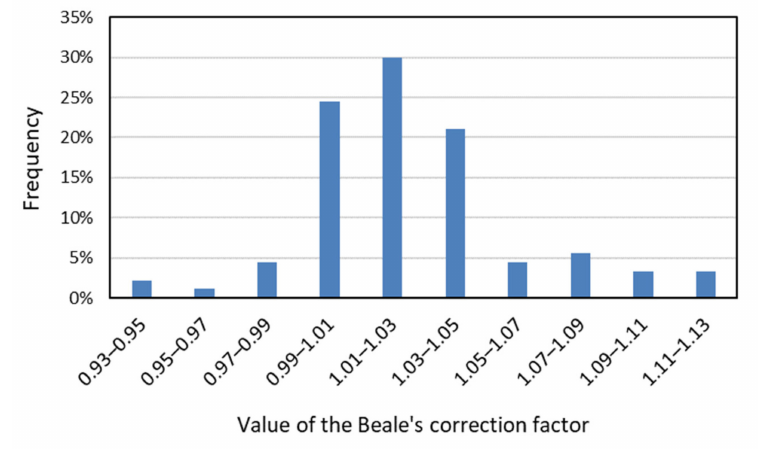
Figure 16. Values calculated for the Beale bias correction